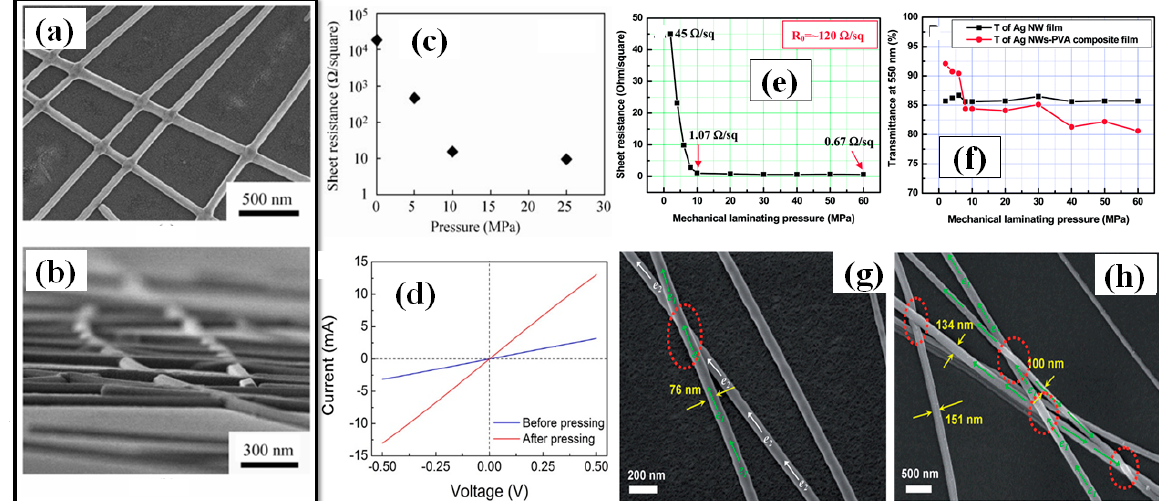
Figure 19. FE-SEM images of rinsed AgNW electrodes pressed at 25 MPa for 5 s ( a ) mechanically compressed AgNWs without any residues can be observed in the top view. ( b ) Tightly connected AgNWs with smooth surfaces can be observed in the off-angle cross-sectional view ( c ) Sheet resistance of a pressed AgNW electrode after pressing at various applied pressures ( d ) the I–V characteristics of Ag NWs before and after pressing. (adapted from [214] with permission from Springer nature 2011). ( e ) Relative plots of the sheet resistance versus the mechanical lamination pressure and ( f ) Relative plots of the transmittance at 550 nm versus the mechanical lamination pressure. ( g ) SEM images of the Ag NW film and ( h ) the Ag NW–PVA composite film on the PET substrate (adapted from [156] with permission from Royal Society of Chemistry,